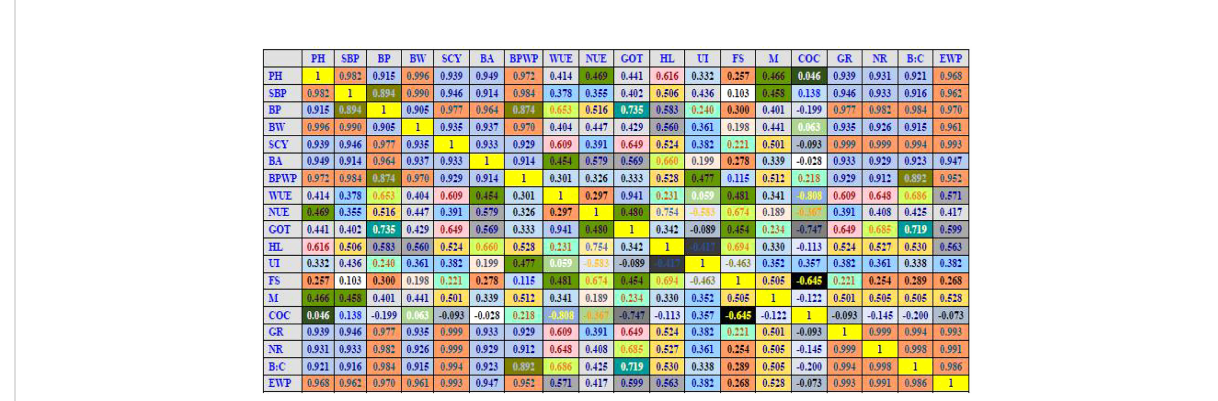
FIGURE 6 Correlation heat map among various traits of cotton. PH, plant height (cm); SBP, sympodial branches plant ⁻ ¹; BP, Bolls per plant; BW, Boll weight (g); SCY, seed cotton yield (kg ha ⁻ ¹); BA, biomass accumulation (g m ⁻ ²); BPWP, bio-physical water productivity (kg m ⁻ ³); WUE, water use ef fi ciency (%); NUE, nitrogen use ef fi ciency (kg SCY kg ⁻ ¹ N); GOT, Ginning turnout (%); HL, halo length (mm); UI, uniformity index; FS, fi ber strength (g tex ⁻ ¹); M, micronaire; COC, cost of cultivation ($ ha ⁻ ¹); GR, gross returns ($ ha ⁻ ¹); NR, net returns ($ ha ⁻ ¹); B:C, bene fi t/cost ratio;